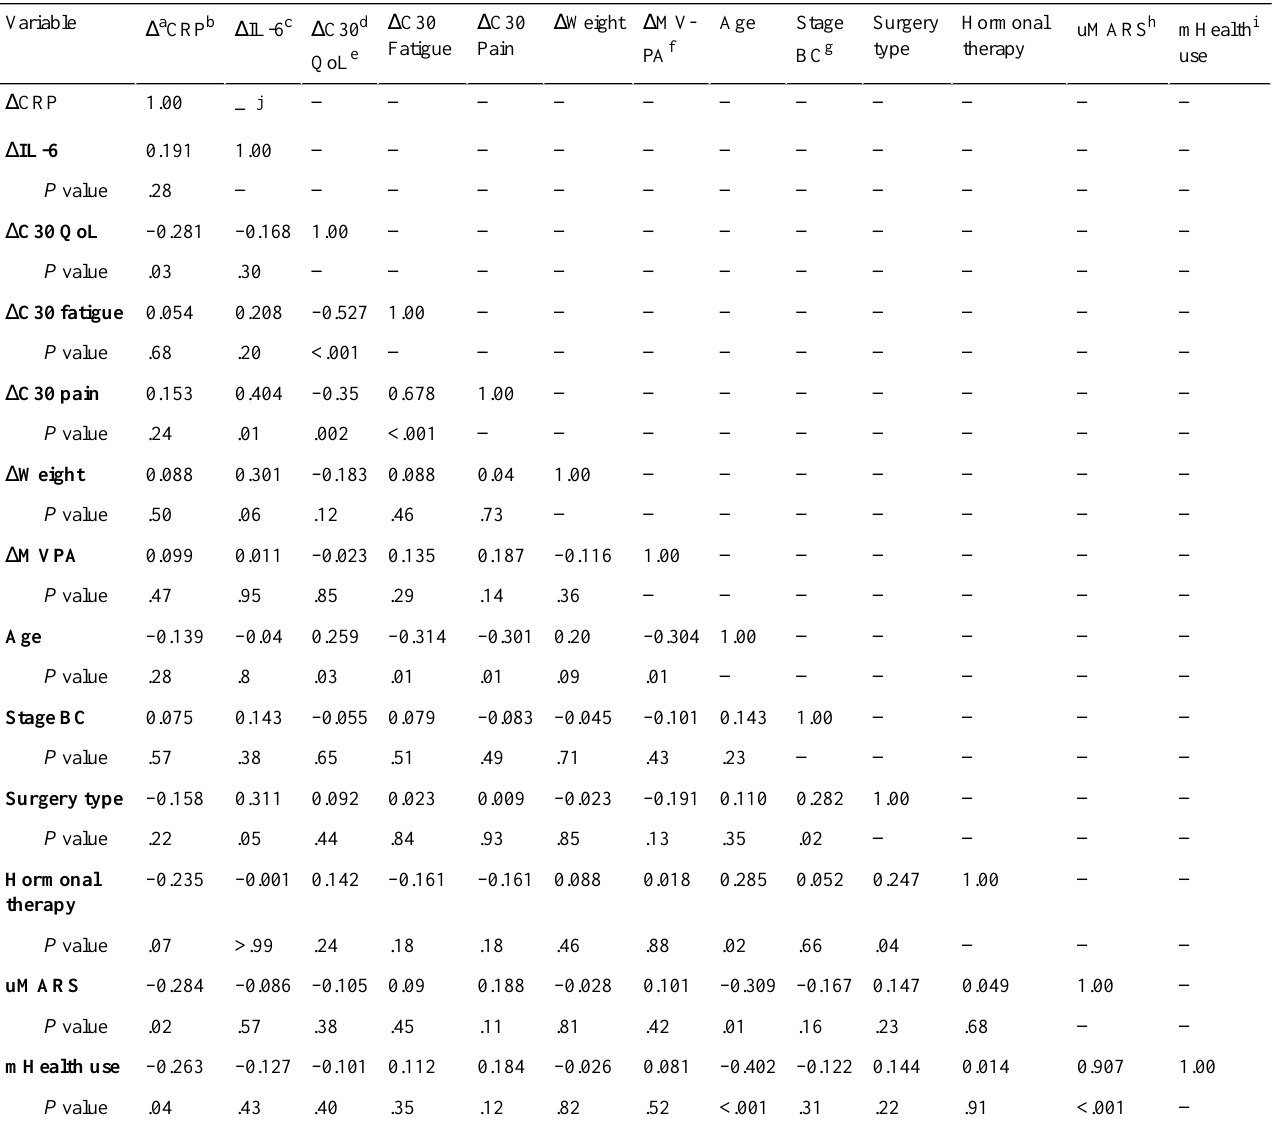
Table 2. Pearson product-moment correlation matrix for study